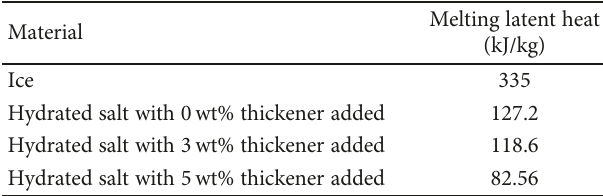
Table 4: Melting latent heat of water and three